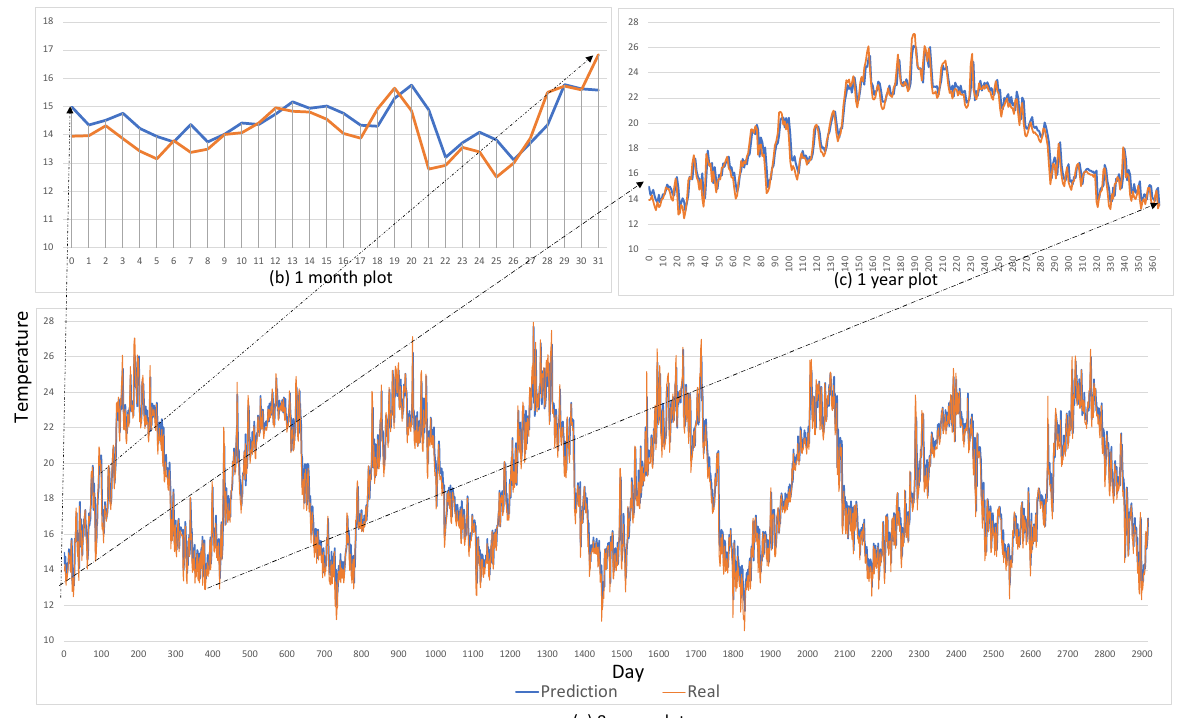
Figure 18. Model validation—Muli-timeframe temperature prediction. ( a ) daily predictions vs. real plot for 8 years (entire dataset). ( b ) daily predictions vs. real plot for 1 month. ( c ) daily predictions vs. real plot for 1